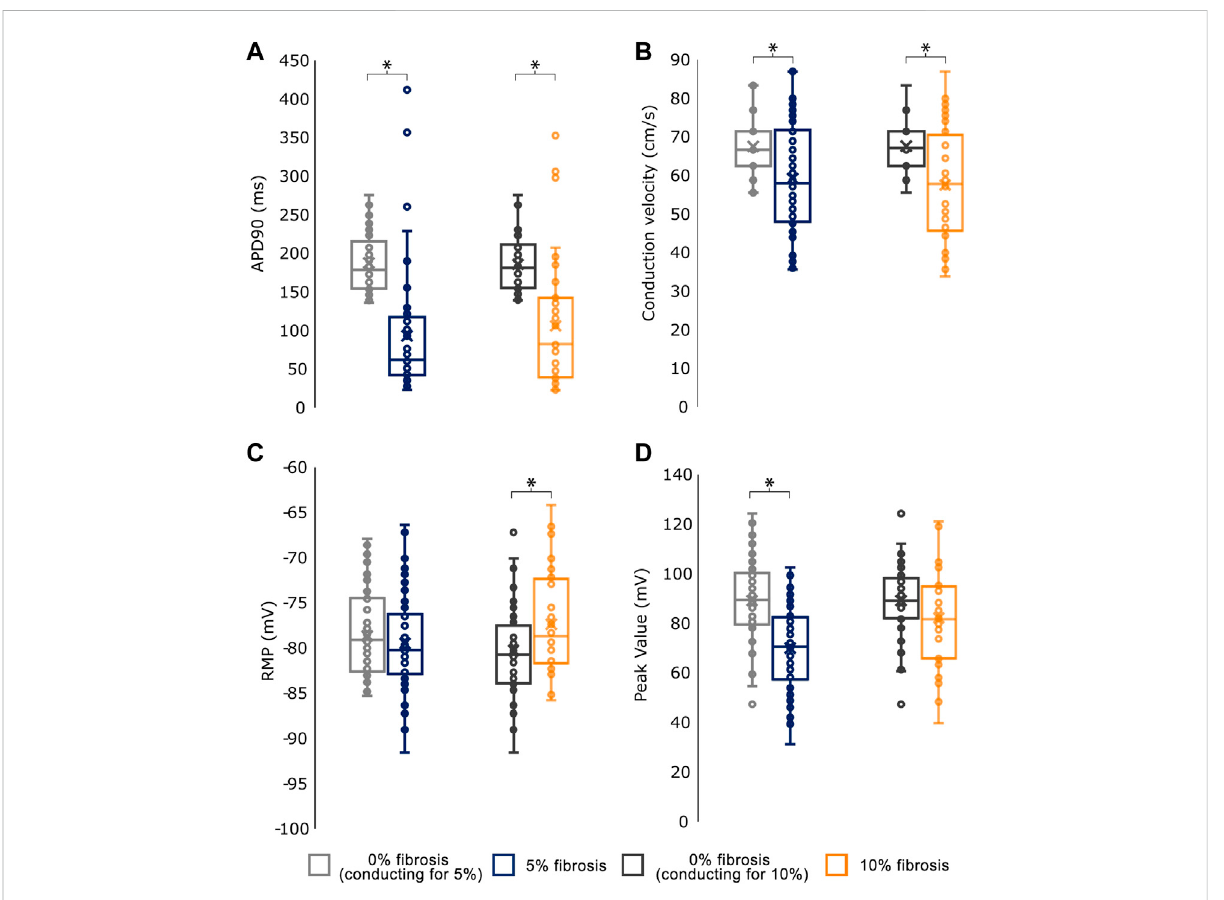
FIGURE 3 Mean values for the electrophysiological characterization of simulations conducting for the different fi broblast concentrations. (A) Action PotentialDurationat90%repolarization(APD90) (B) Conductionvelocity (C) RestingMembranePotential(RMP)and (D) PeakTransmembraneValue. As the number of pro fi les conducting in each group (0%, 5% and 10% fi brosis) differ, each group is compared against the basal (0% fi brosis) electrophysiological values of the same pro fi les.* < .05 for t -test statistical test.